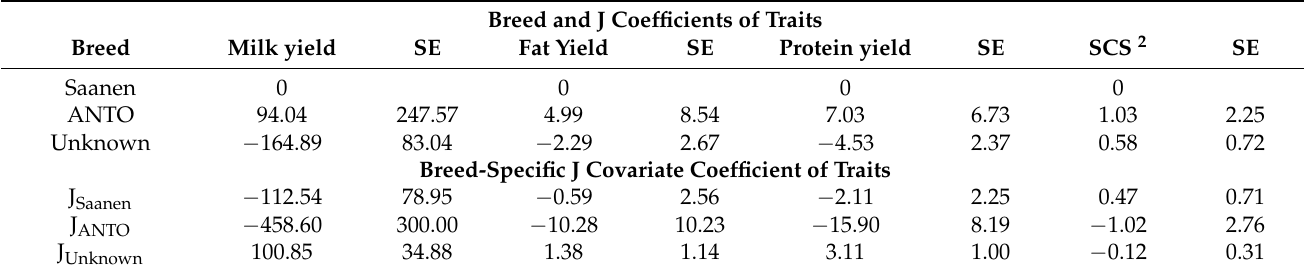
Table 5. Estimated breed and J covariate coefficients and standard errors (SE) of the milk traits obtained from the ssBC 1 model. Breed and J Coefficients of